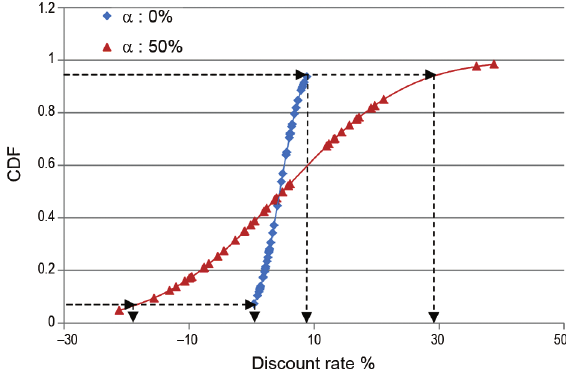
Fig. 7. Normal cumulative distributions for discount rates regarding energy related items ( r 1 ) and time related items ( r 0 ) for Sweden during 1970–2012